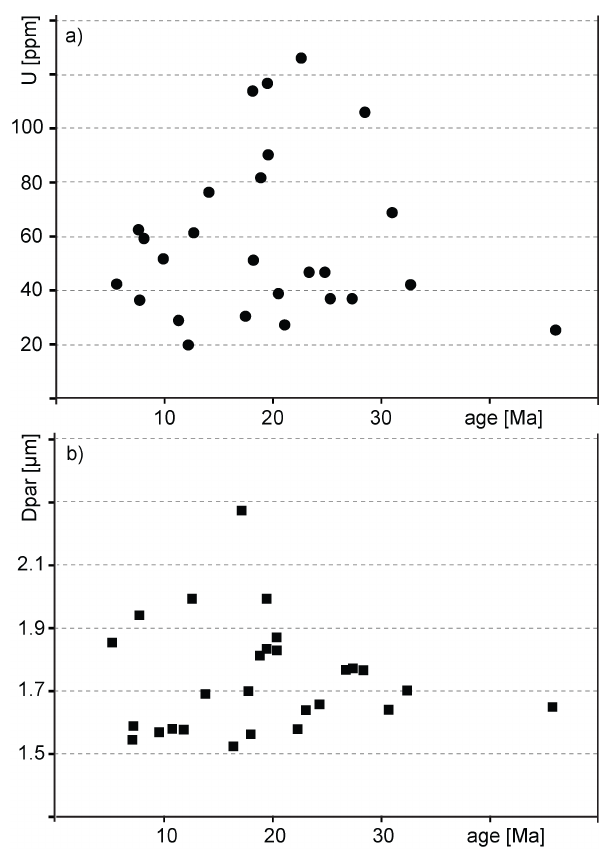
Figure 9. Plots of single apatite measurements of sample 09-055; (a) U concentration vs. age and (b) dpar vs.